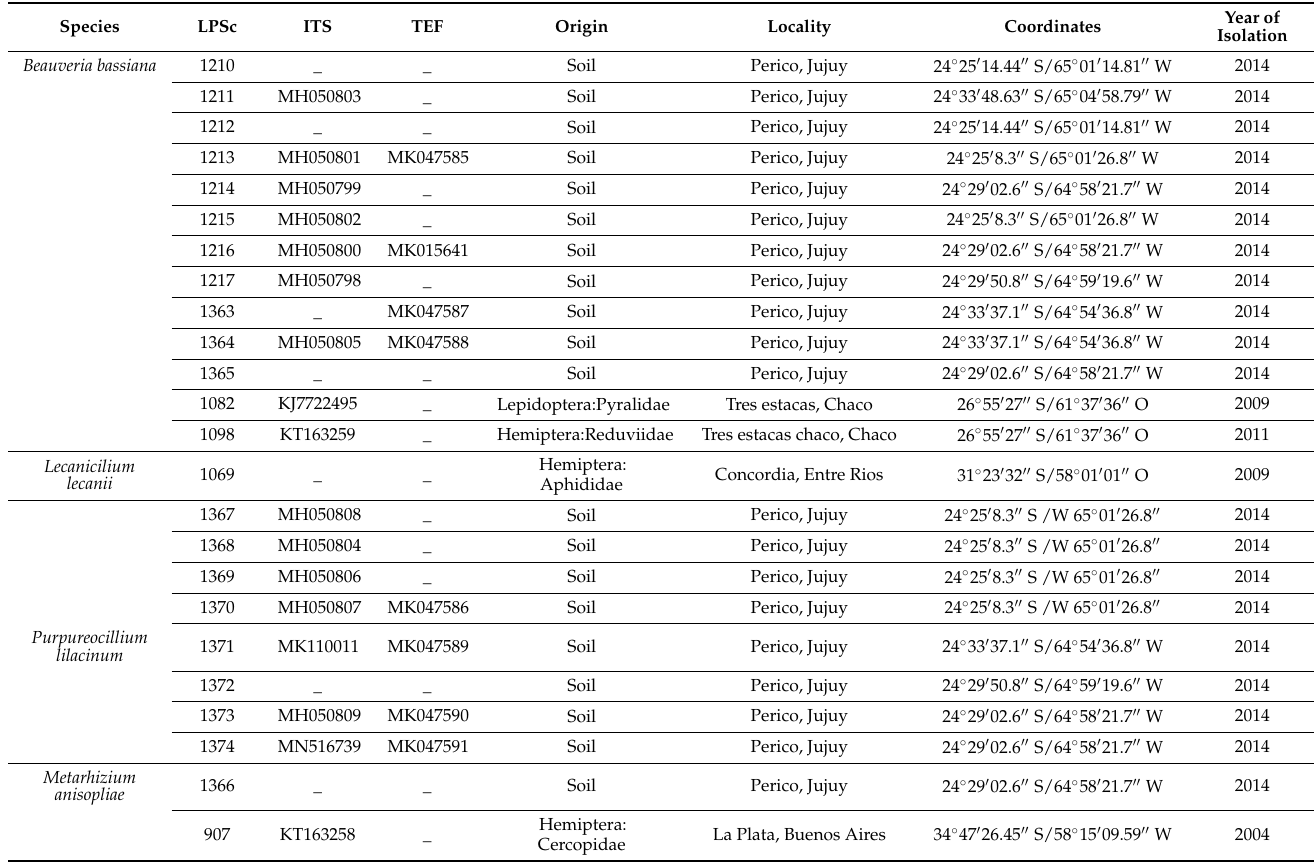
Table 1. Strain origins of fungal